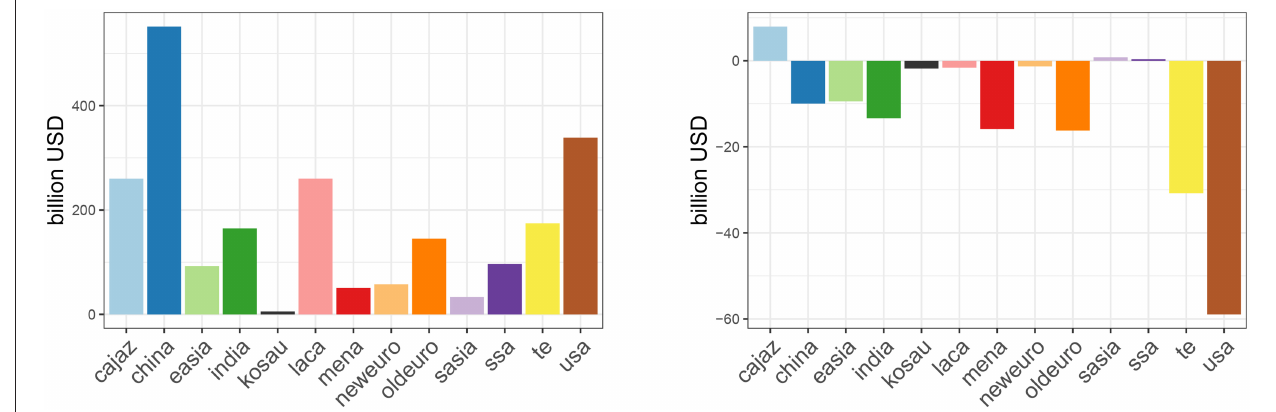
FIGURE 7 | Total value of leaked emission by 2100 in scenario 550 with leakage rate of 0.1 % / year (NN, left ), and difference when priced (between YY and YN, right ).